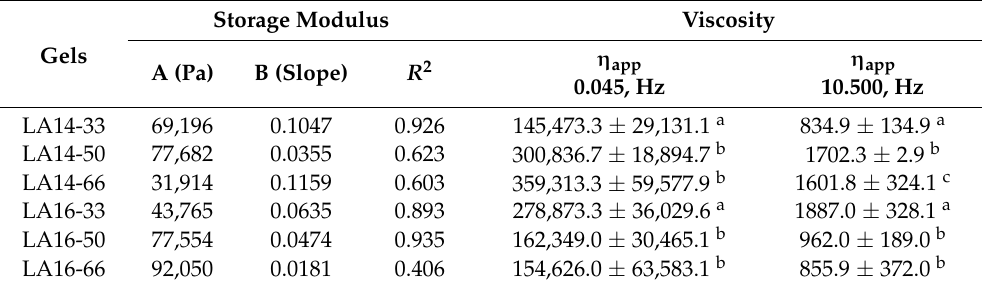
Table 2. Summary of power law parameters for relationship between storage modulus or viscosity and frequency (0.01 < ω < 50.00 or at 0.1/10.5 Hz) of 3D-printed gel.